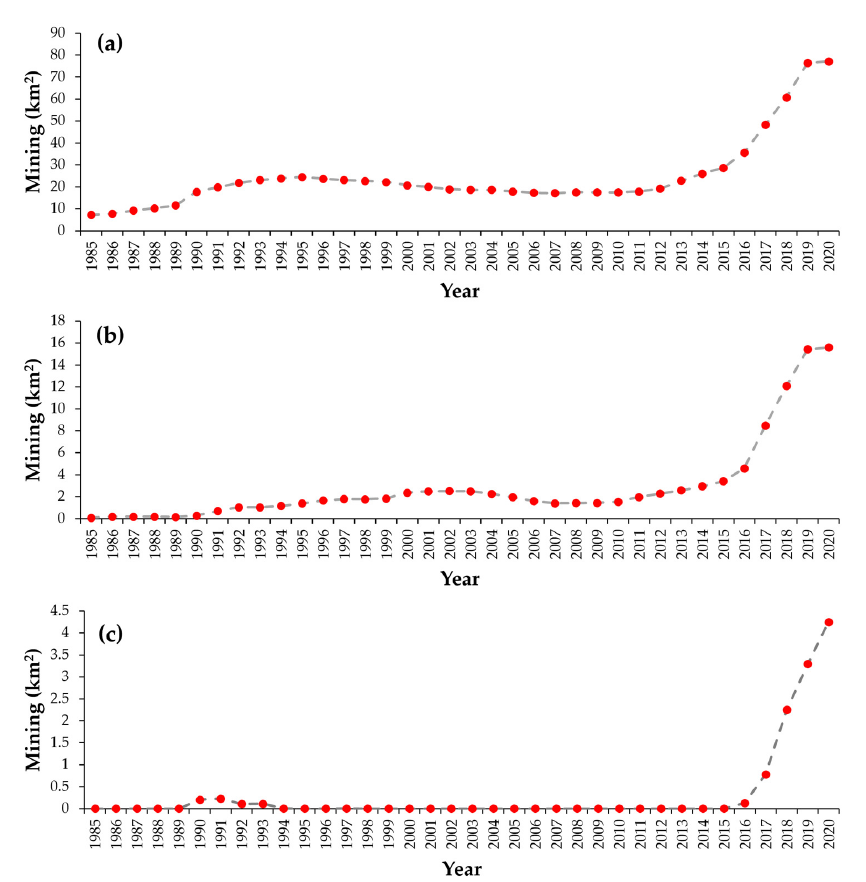
Figure 3. Total area (km 2 ) classified as mining by the MapBiomas LULC dataset collection 6